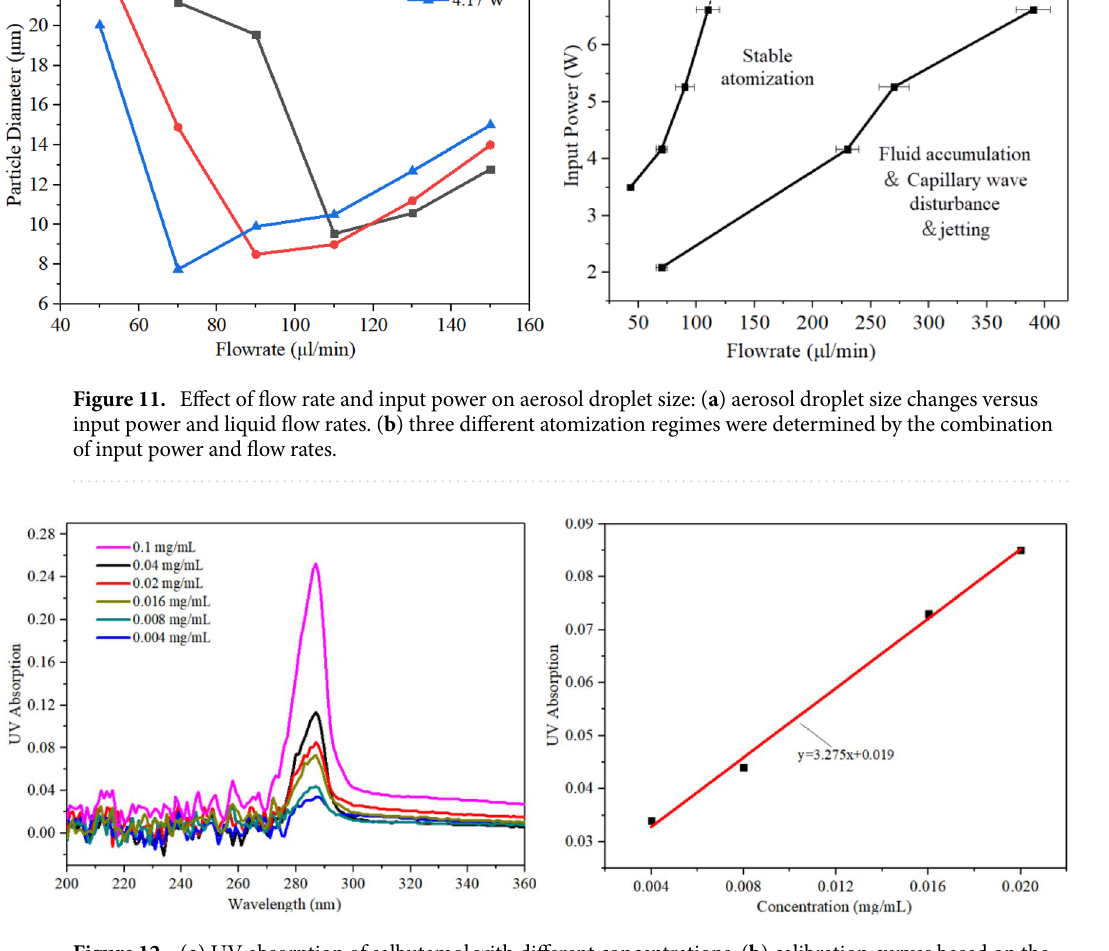
Figure 12. ( a ) UV absorption of salbutamol with different concentrations. ( b ) calibration curves based on the absorption peaks obtained in (a) used for the dose measurements from the different areas in the glass